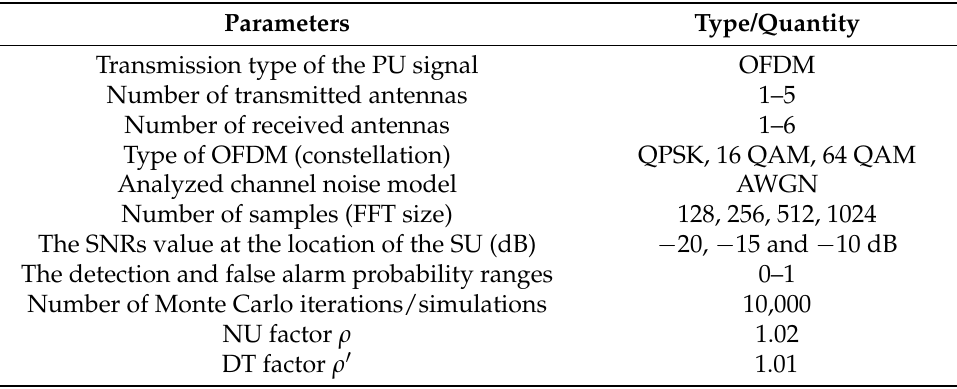
Table 2. Simulation